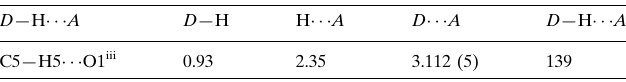
Hydrogen-bond geometry (A˚ , (cid:2)